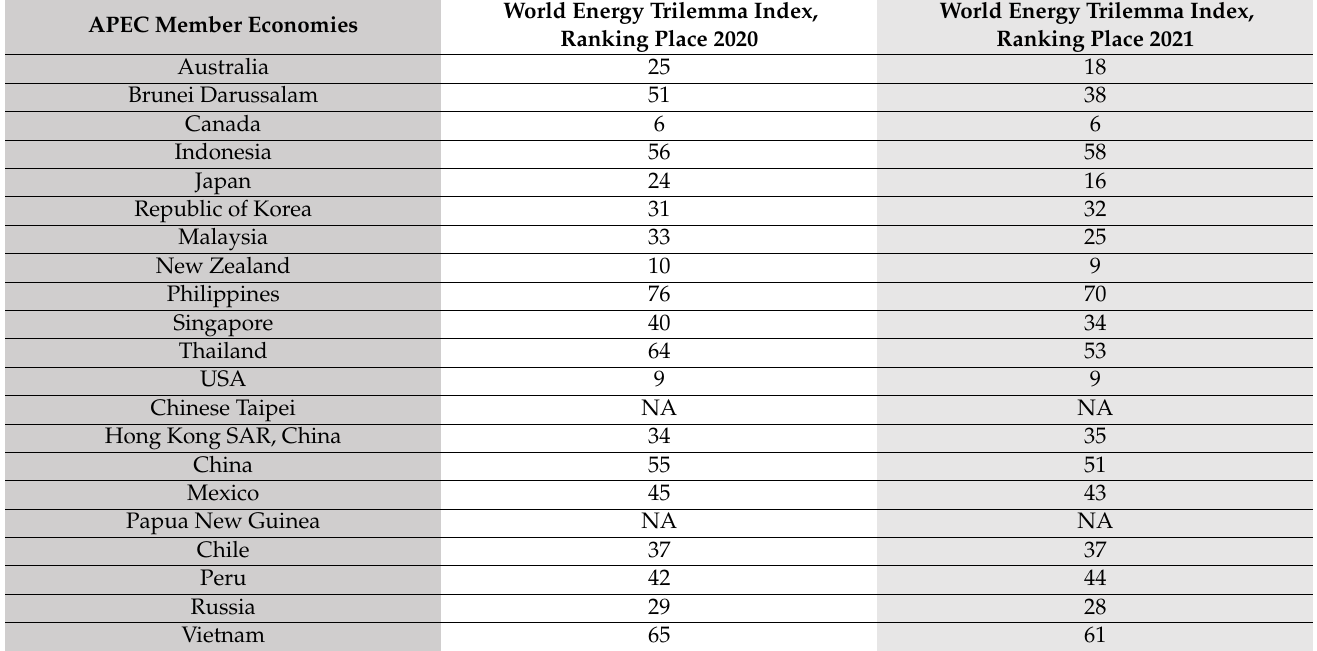
Table 3. Positions of the APEC member economies in the ranking on the World Energy Trilemma Index. World Energy Trilemma APEC Member Economies